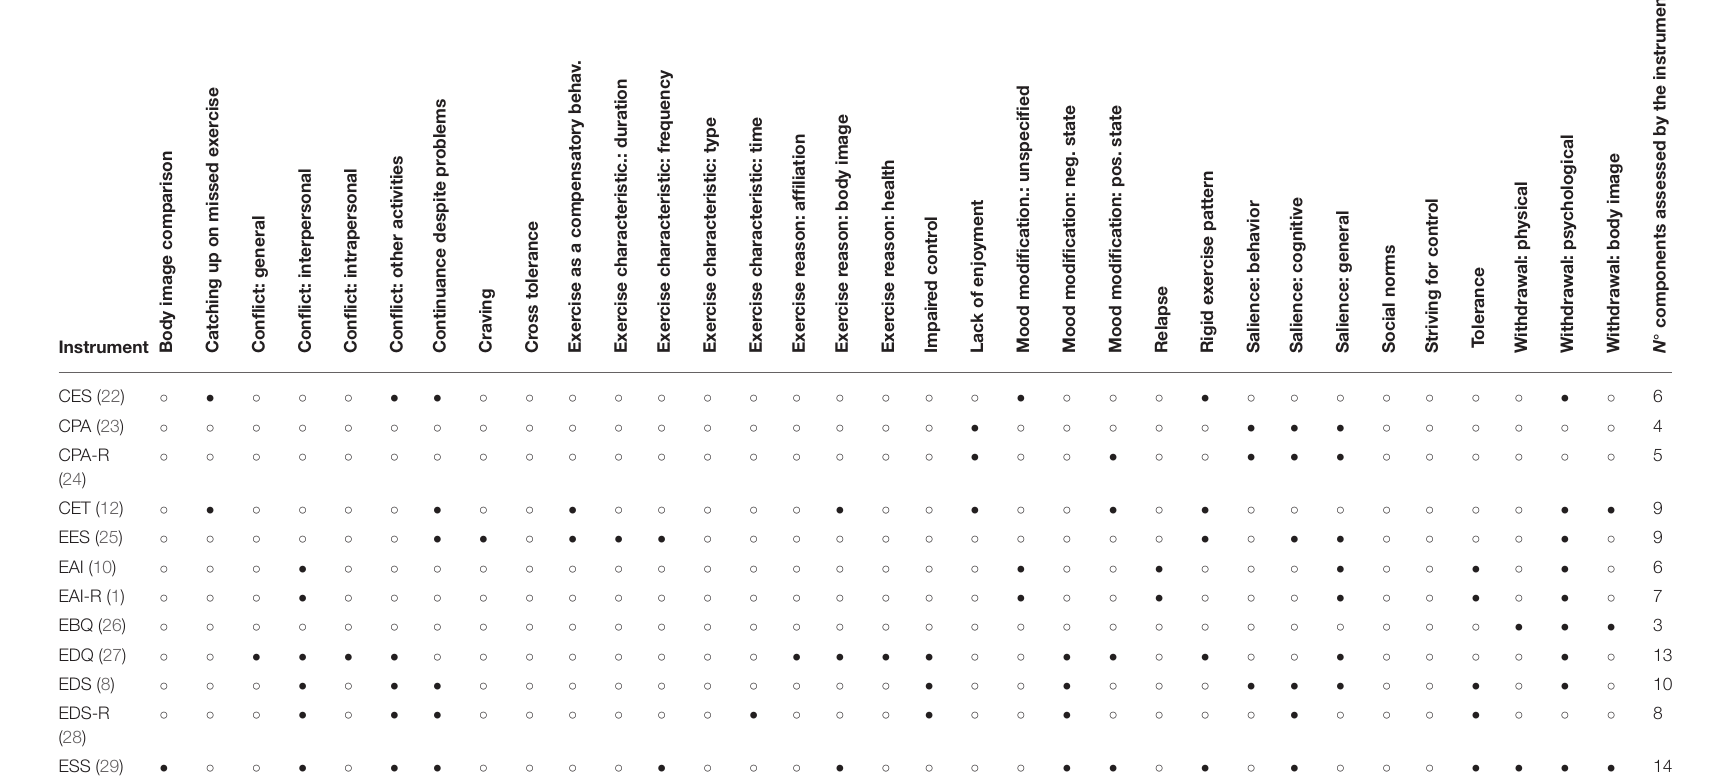
TABLE 2 | Components assessed by psychometric instruments.